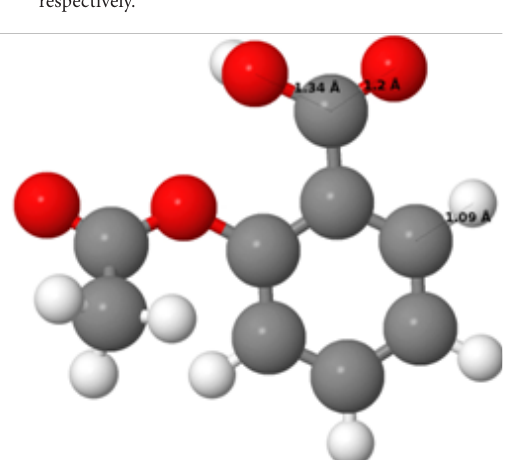
Fig. 4. Structure of the aspirin molecule before the adsorption process with bond length results. Colors represent atoms accordingly: C in gray, O in red and H in